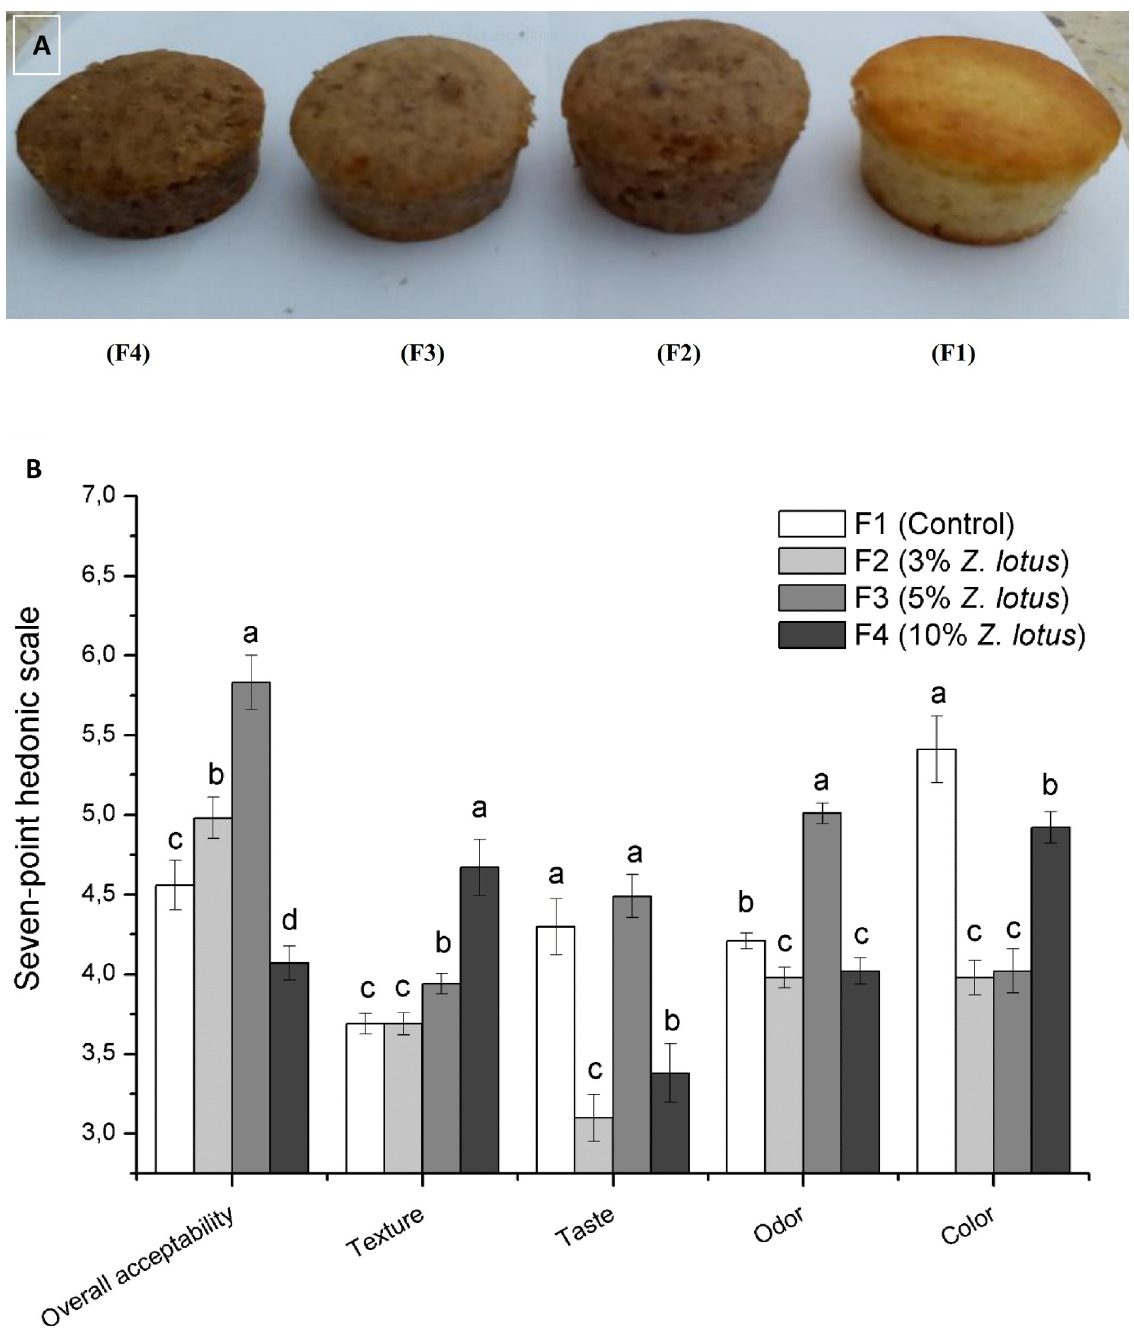
Fig 1. (A) Cake prepared with 3% (F2), 5% (F3) and 10% (F4) of Z . lotus fruit powder. (B) Sensory evaluation of the formulated cakes. The control (F1) represented the product without enrichment. The attributes were evaluated using a seven-point hedonic scale, where 7: